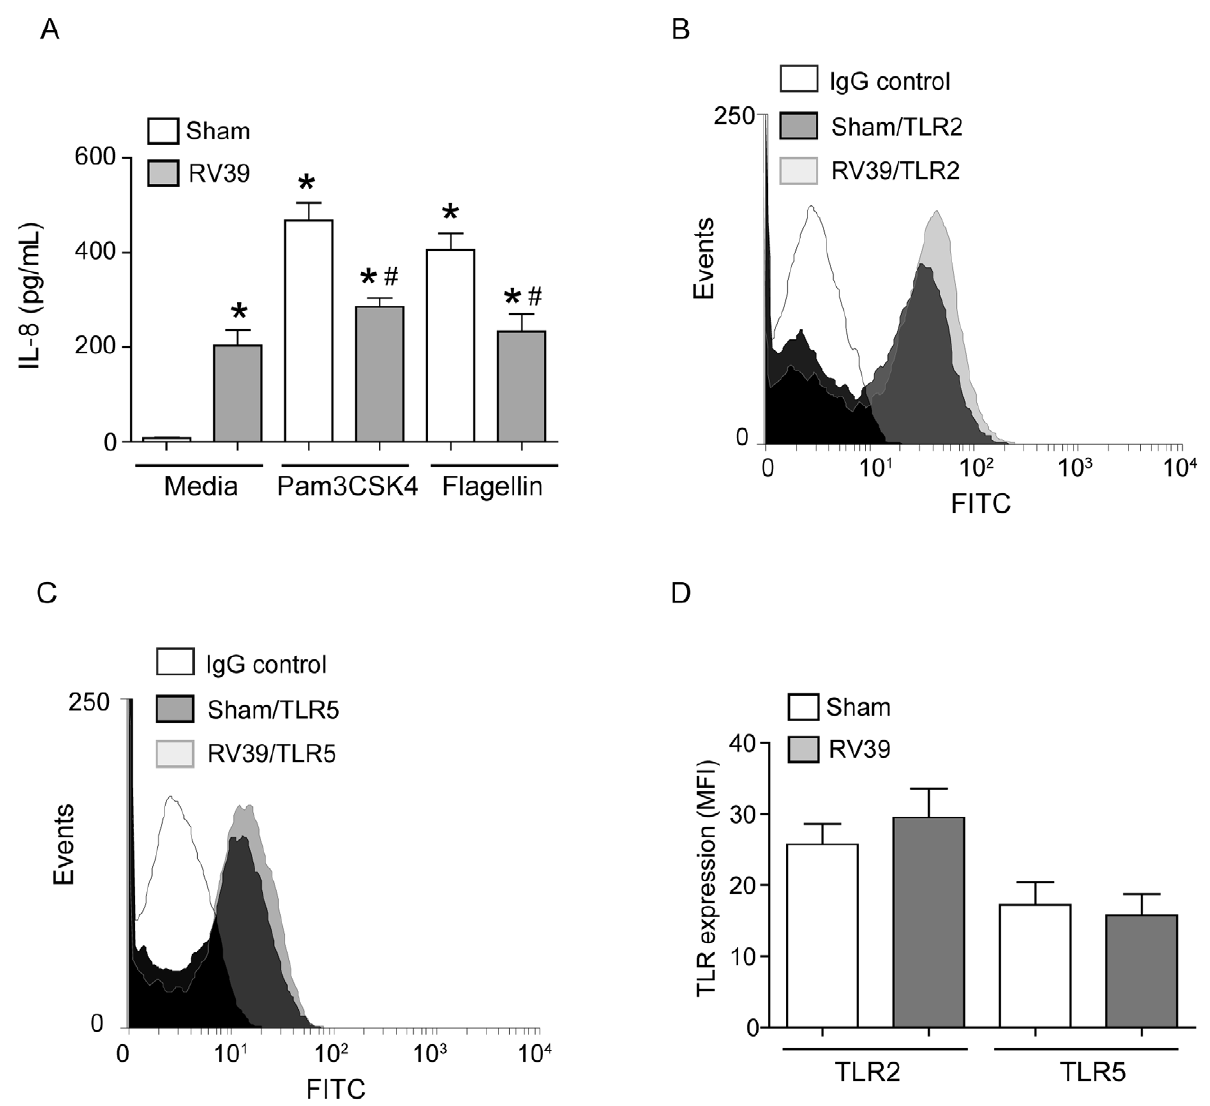
Figure 4. RV suppresses TLR2 or TLR5 ligands-elicited IL-8 production without affecting TLR2 or TLR5 expression. (A) BEAS-2B cells were infected with RV39 or sham as described under figure 2 and then treated with Pam3CSK4 (TLR2 agonist), or flagellin (TLR5 agonist) and incubated for 6 h. IL-8 protein levels in the cell culture supernatants were determined by ELISA. (B, C and D) BEAS-2B cells were infected with RV39 or sham, blocked and incubated with antibodies to TLR2 or TLR5 followed second antibody conjugated with Alexafluor-488 and analyzed by flow cytometry. Histograms are representative of three independent experiments. Data in A and D represents mean 6 SEM calculated from 3 independent experiments performed in duplicate (* p # 0.05, ANOVA, different from sham; # , p # 0.05, ANOVA, different from sham/TLR2 or sham/TLR5